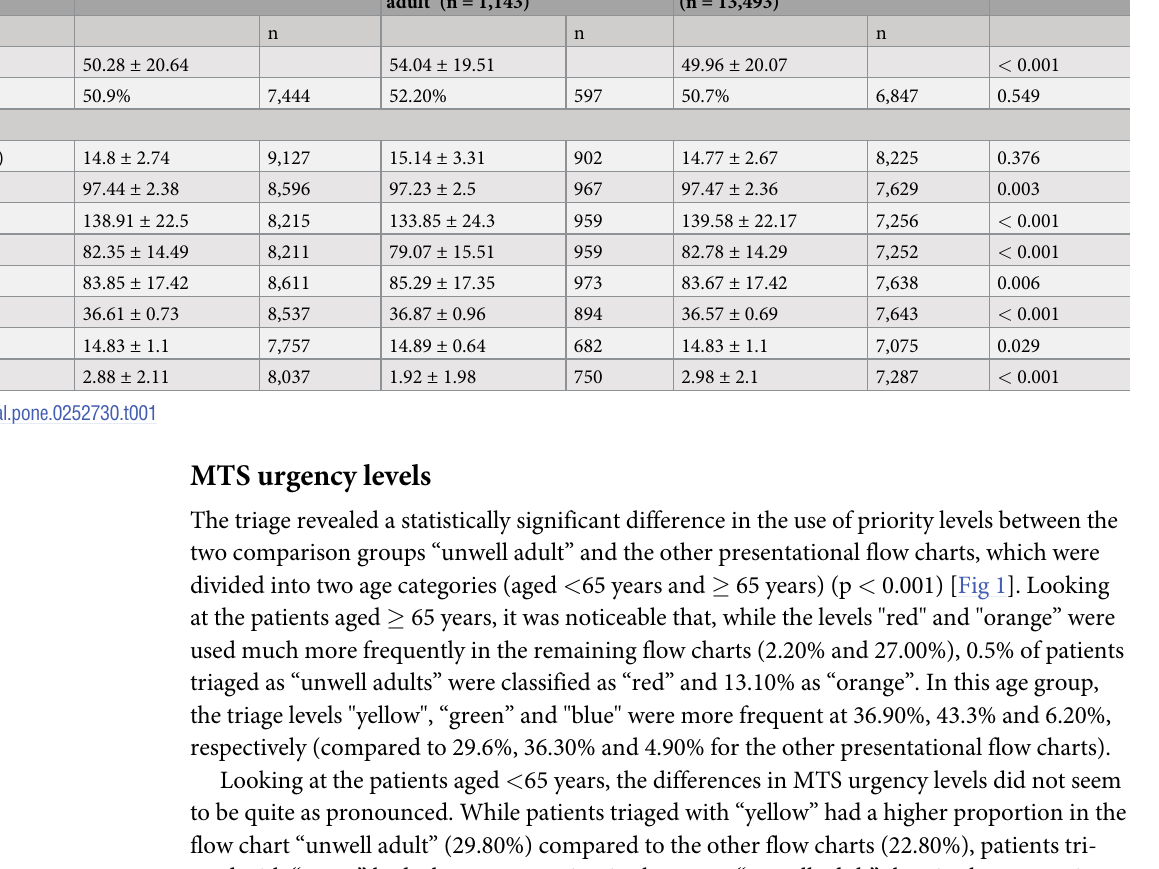
Table 1. Baseline characteristics (mean value with standard deviation) of the presentational flow chart “unwell adult” of the MTS in comparison to the other pre- sentational flow charts. over-all (n =